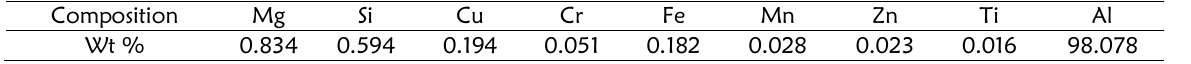
Table 2: Chemical composition of 6xxx aluminium